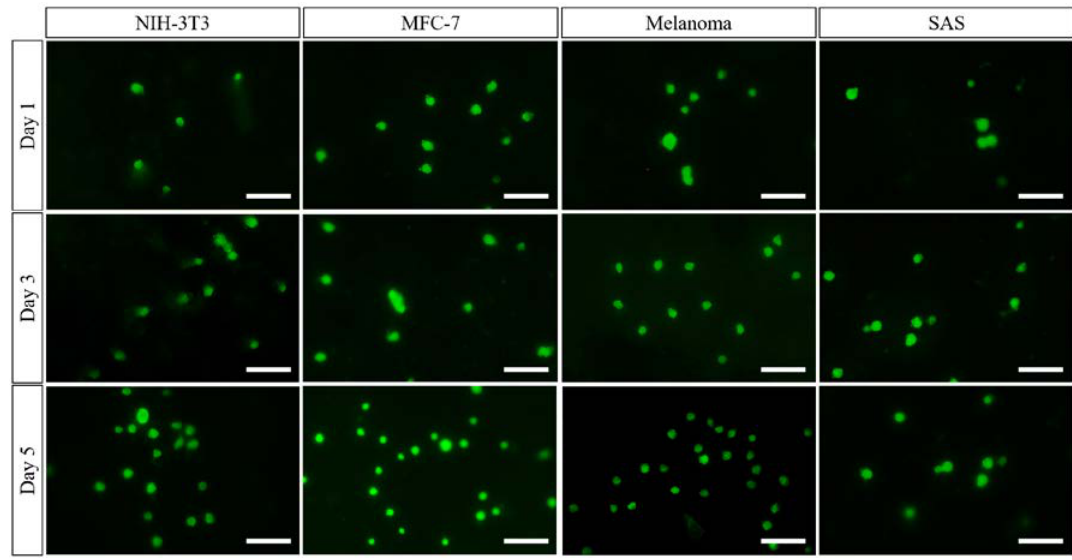
Figure 6. Fluorescent images of the four kinds of cells that were cultured on the optimised nanofibrous meshes after five days. The images showed the proliferation and spreading of four kinds of cells (i.e., MCF-7 cells, NIH-3T3 fibroblast cells, SAS cells, and melanoma cells) which supported the biocompatibility of PCL nanofibrous meshes. The scale bar is 50 µm.